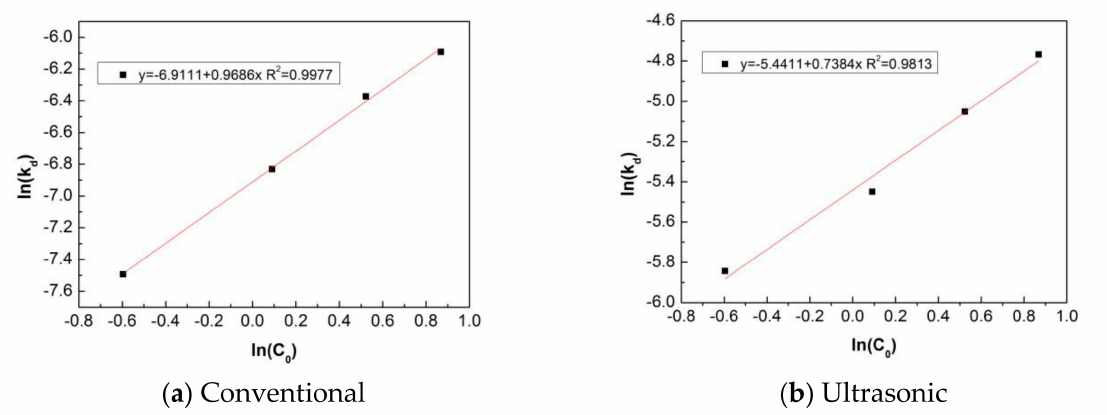
Figure 12. Relationship between ln k d and ln C 0 .